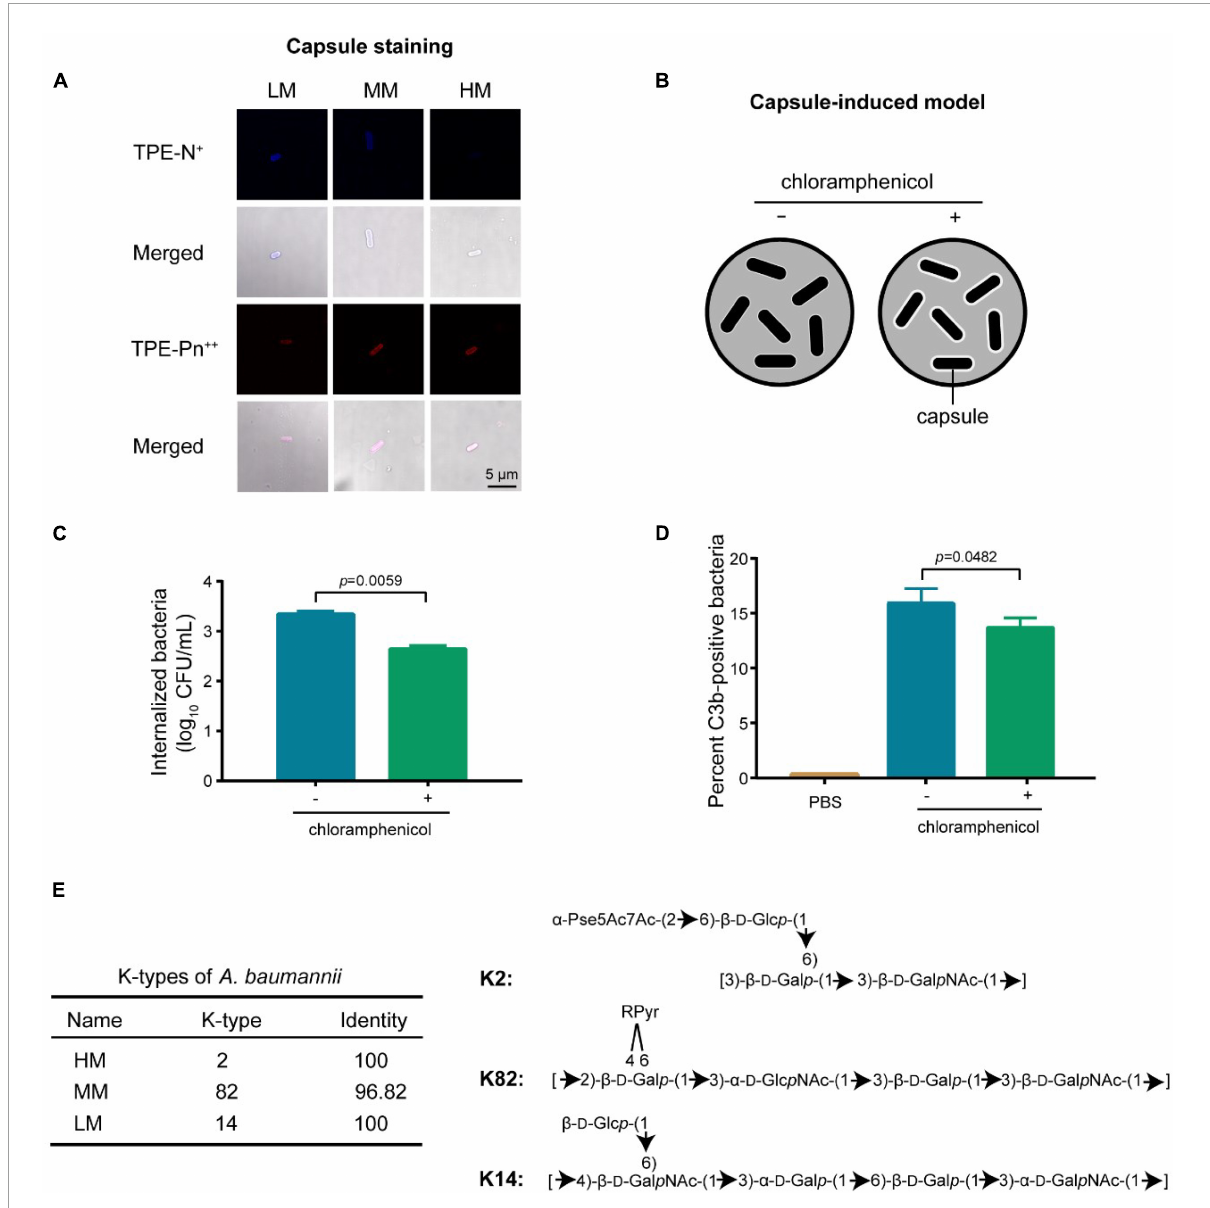
FIGURE5 Capsular changes decreases the C3b deposition. (A) Confocal images of single charged probe TPE-N + (20 µ M) and zwitterionic probe TPE-Pn ++ (20 µ M). Scale bar = 5 µ m. (B) Scheme of the introduction of hyper-production of capsule in A. baumannii . (C) CFUs of internalized bacteria in MH-S cells. Cells are infected with chloramphenicol-treated (10 µ g/mL) A. baumannii ATCC 17978 at MOI of 10 for 4 h. (D) Quantitative analysis of C3b-positive bacteria by flow cytometry. Experiments in panels (C,D) were performed as three biologically independent experiments, and the mean ± s.d. was shown. P values were determined using an unpaired, two-tailed Student’s t -test. (E) Structural prediction of the repeating unit in capsule from mucoid A. baumannii